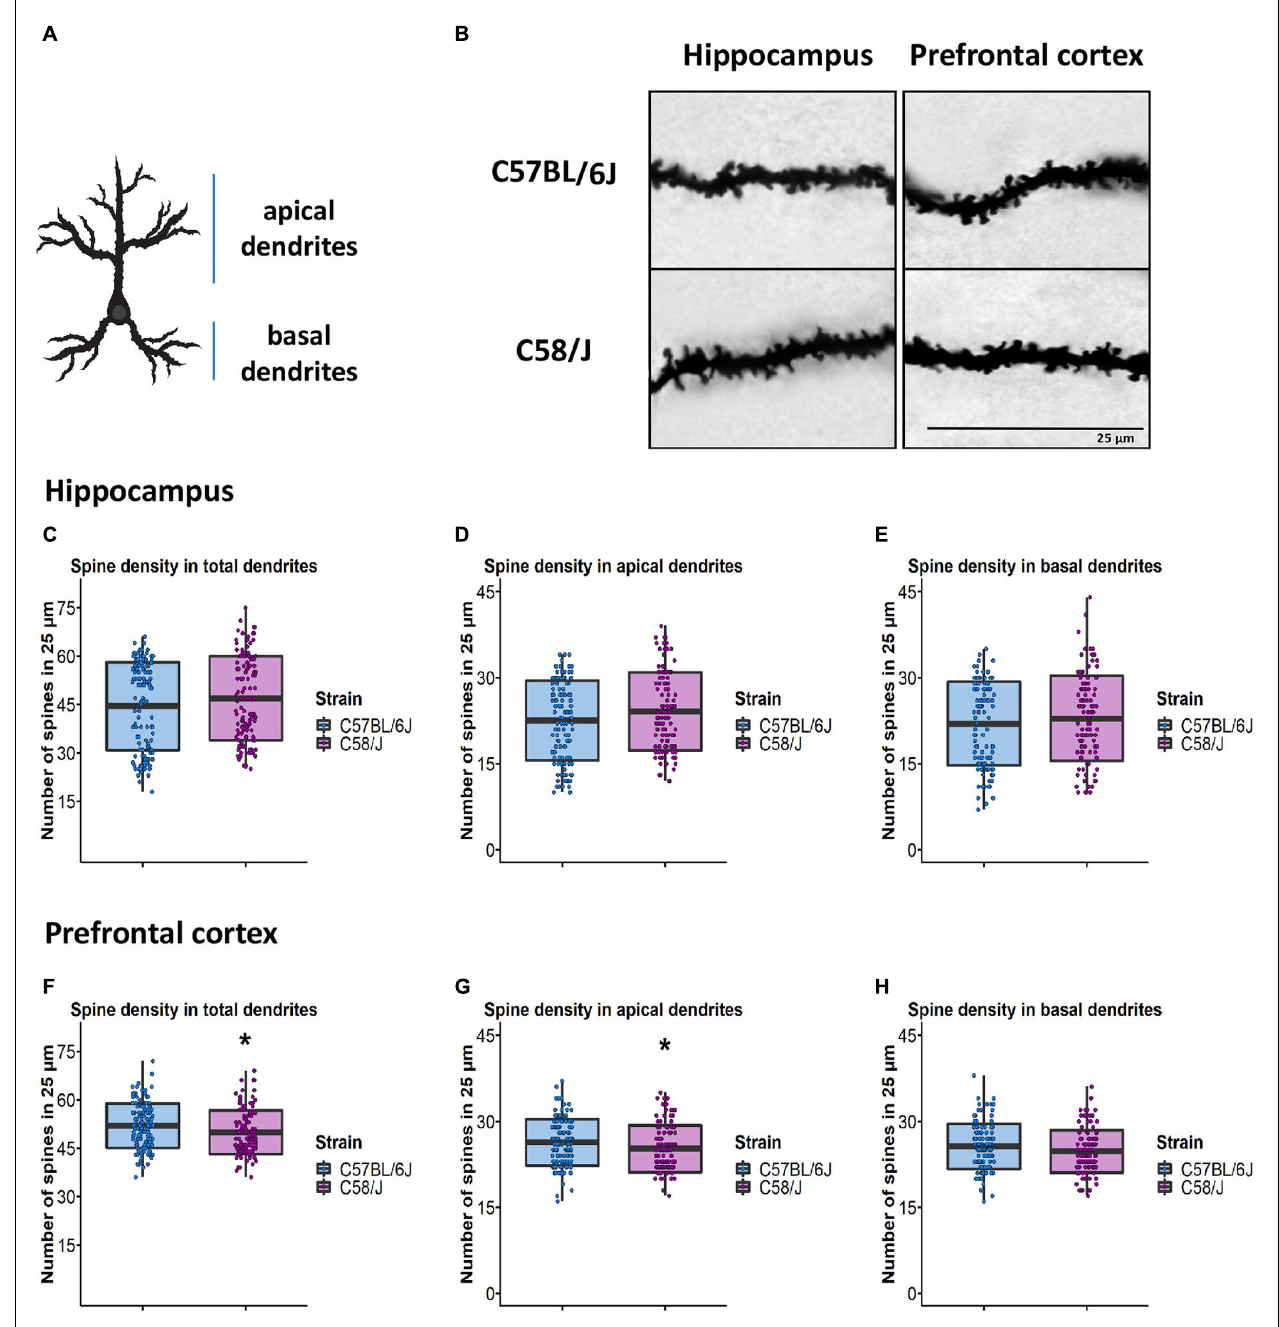
FIGURE 2 | Determination of spine density in the pyramidal neurons of the hippocampus and the prefrontal cortex of C58/J mice. Scheme of apical and basal dendrite location (A) . A representative image of dendritic spines in the hippocampus and the prefrontal cortex of C57 BL/6J (neurotypical phenotype) and C58/J (autistic-like phenotype) mice (B) . Quantification of spine density per 25 µ m in total, apical, and basal dendrites of the hippocampus (C–E) and the prefrontal cortex (F-H) in both mouse strains. Results are expressed as mean ± SD; n = 20 neurons per strain, five neurons per mouse. t -test: * p < 0.05.